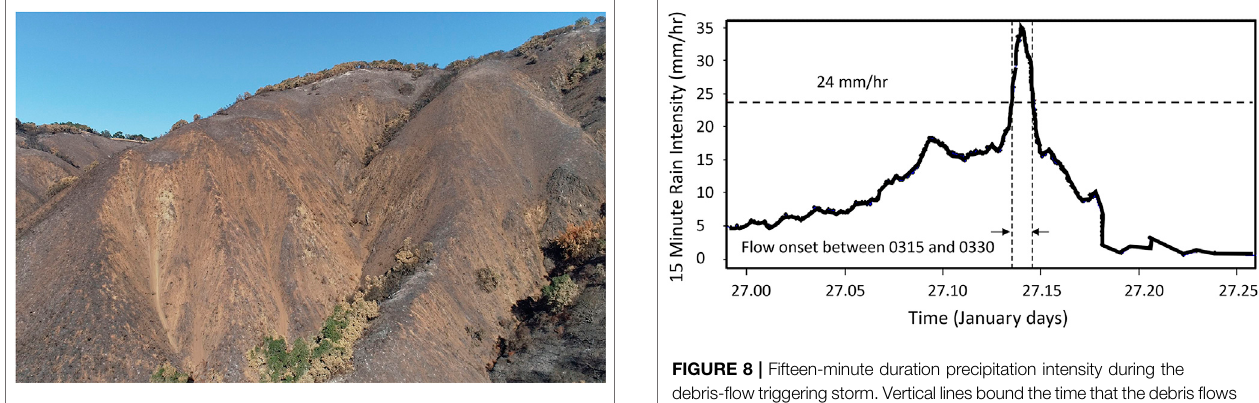
FIGURE7| Burnedslopesbeforethewinterrainsof2021.Thisexample is basin seven of Figure 4 and Table 2 .